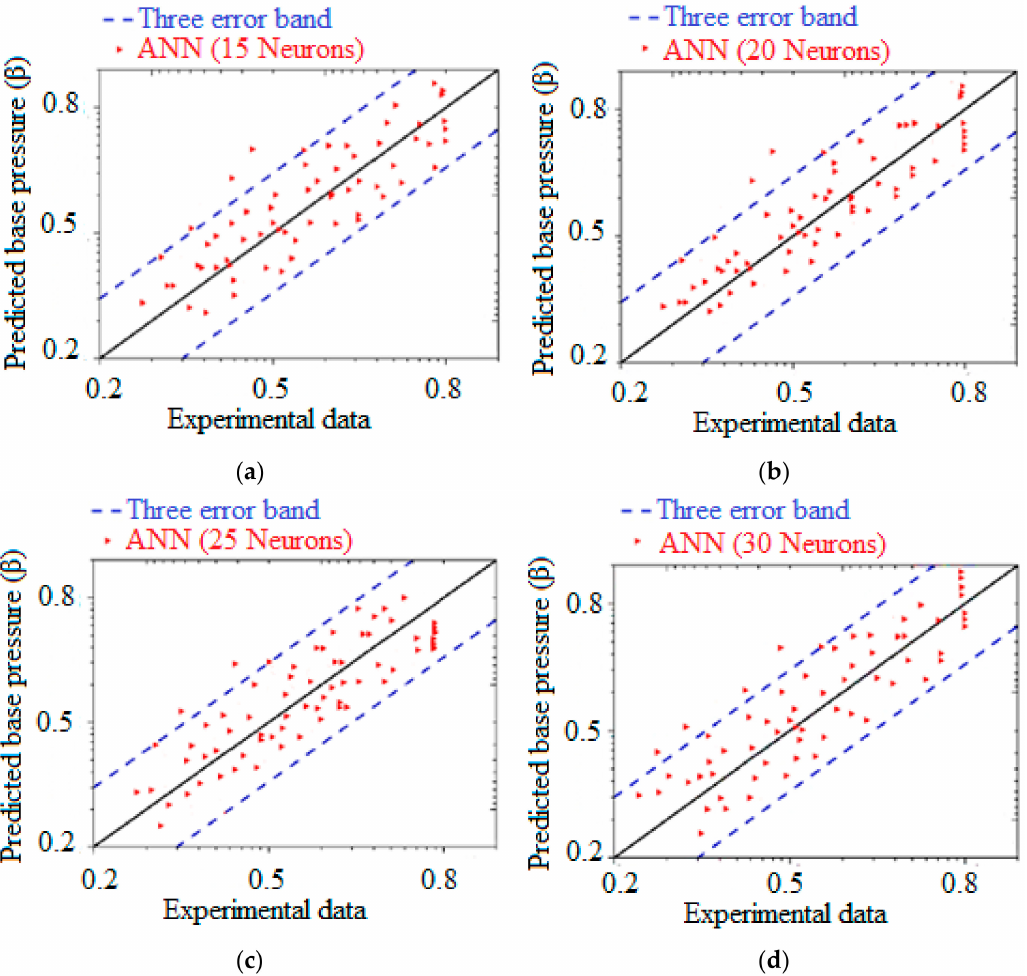
Figure 10. Variation of ANN predicted base pressure ( β ) against experiments: ( a ) 15 neurons, ( b ) 20 neurons, ( c ) 25 neurons, ( d ) 30